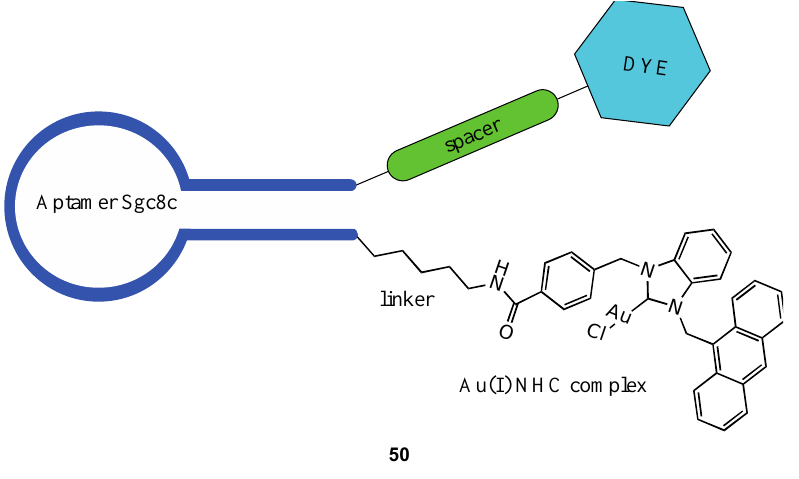
Figure 32. Structure of the bioconjugate 50 .